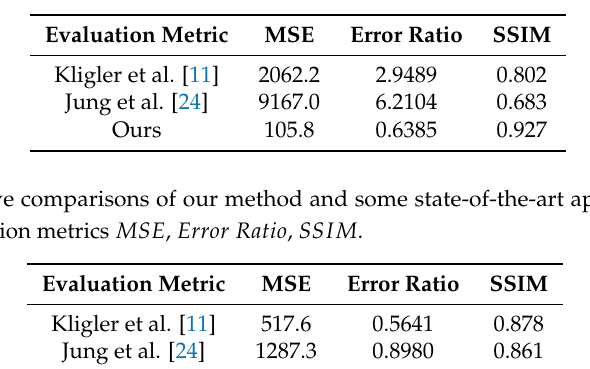
Table 1. Quantitative comparisons of our method and some state-of-the-art approaches for the Adobe dataset with evaluation metrics MSE , Error Ratio , SSIM .